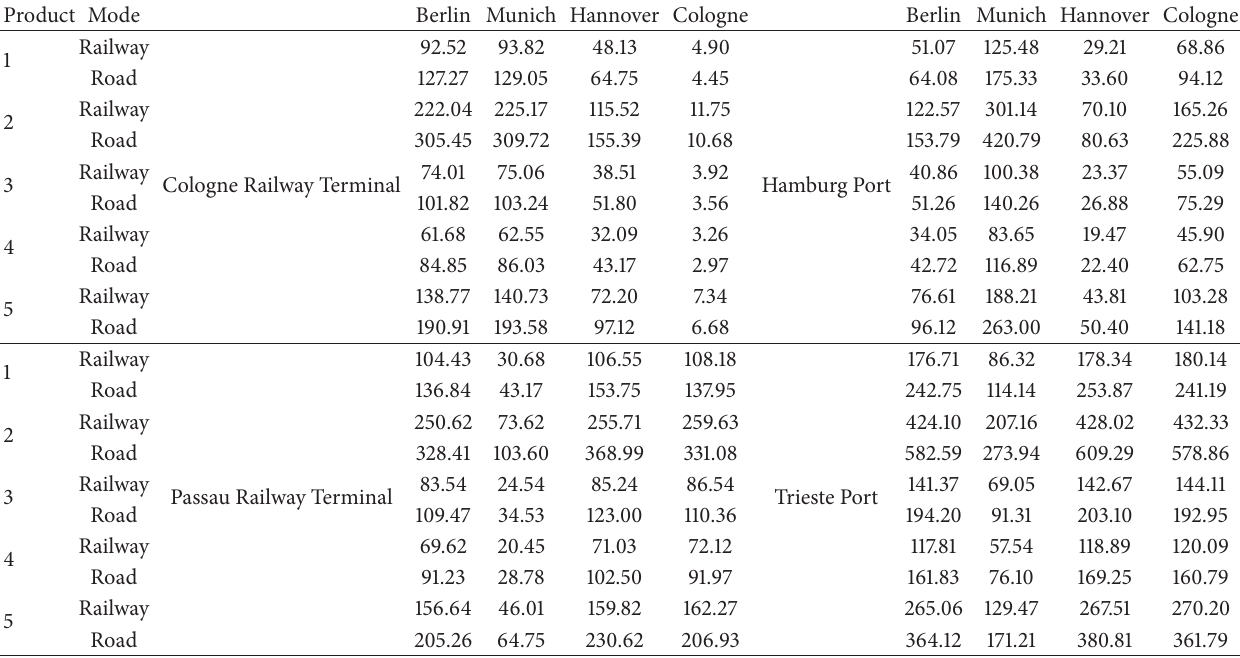
Table 3: Transportation costs from the manufacturing facilities to the first level from transshipment terminals (TL/unit product). Product Mode